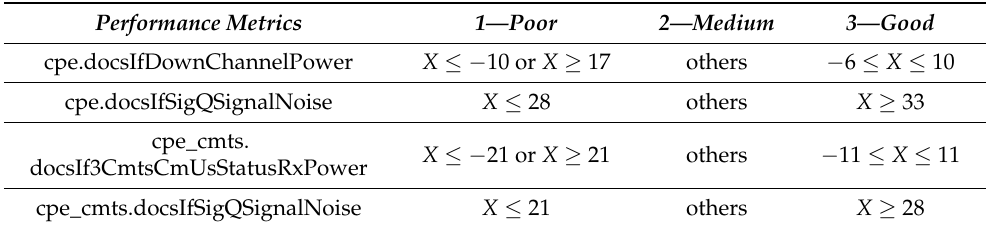
Table 4. Mapping of performance metrics onto the unified grade scale.